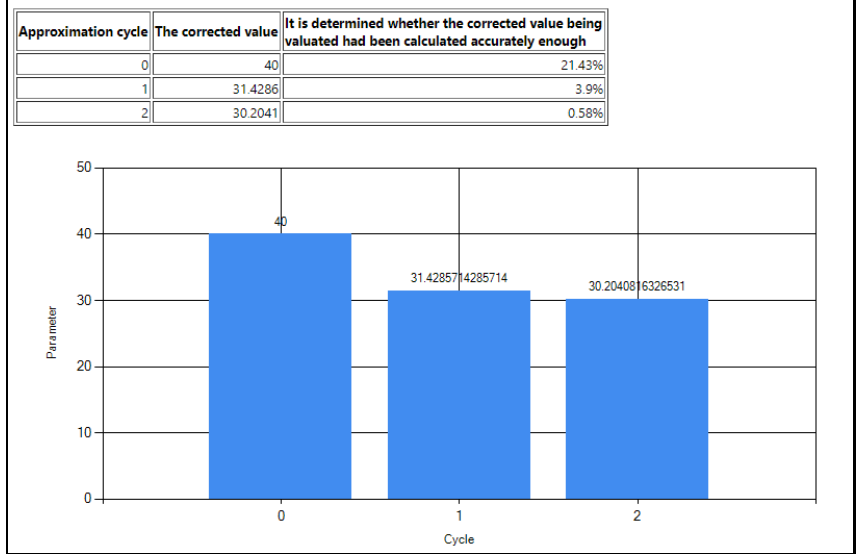
Figure 6. The “Kauno šilas 1” insulation market value analysis.